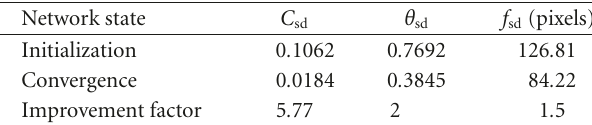
Table 3: Summary of the calibration consistency. C sd is the average standard deviation of error in camera centers (in arbitrary units). θ sd is the average standard deviation of orientation error between rotation matrices given by (15). f sd is the average standard deviation of absolute focal length error in